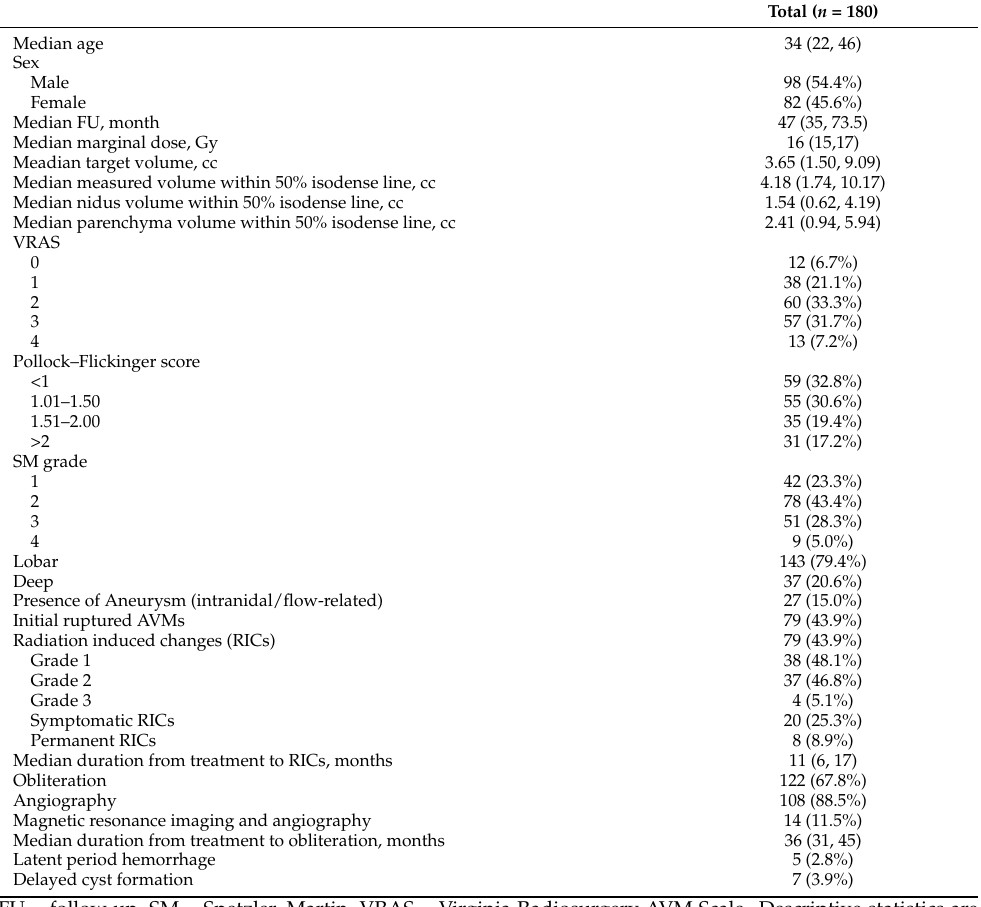
Table 1. Patient demographics, arteriovenous malformation (AVM) characteristics, radiosurgical parameters, and treatment